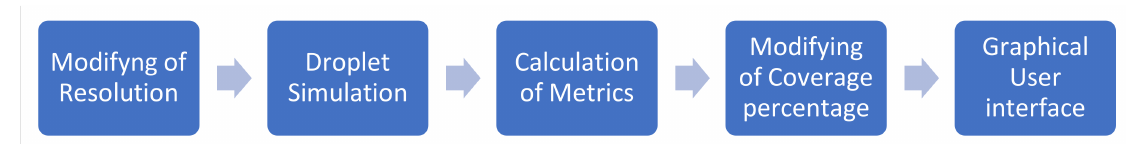
Figure 6. Main components of the developed simulation tool.